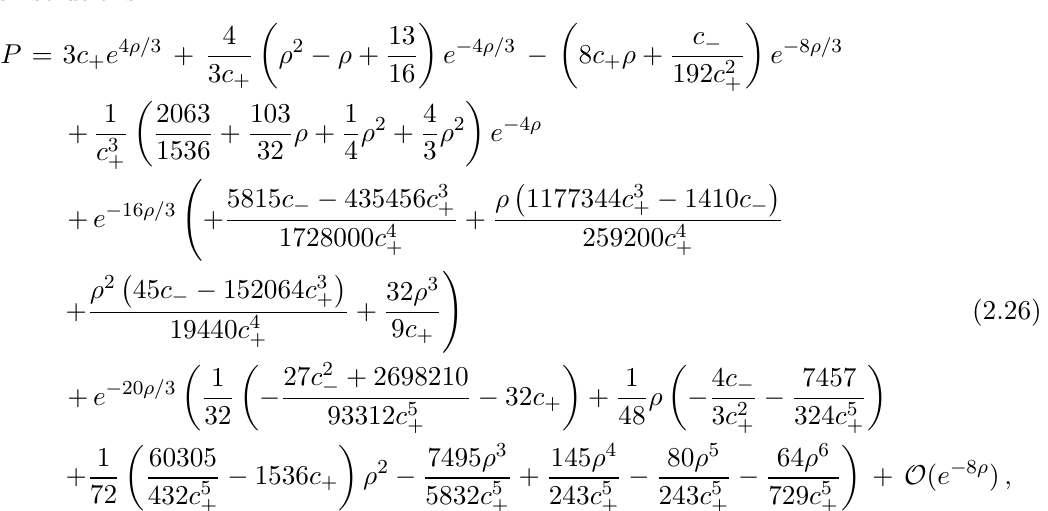
4, but has P P 0 for (cid:26) < (cid:26) (cid:3) . In red (long dashing) ’ (cid:24) 9, but behaves as P e 4 (cid:26)= 3 for (cid:26) > (cid:22) (cid:26) . In ’ / P 0 for (cid:26) < (cid:26) (cid:3) 8, behaves as P 2 (cid:26) for (cid:26) (cid:3) < (cid:26) < (cid:22) (cid:26) 14, ’ ’ ’ ’ e 4 (cid:26)= 3 for (cid:26) > (cid:22) (cid:26) . In orange a solution for which P 2 (cid:26) for all (cid:26) , / (cid:29)